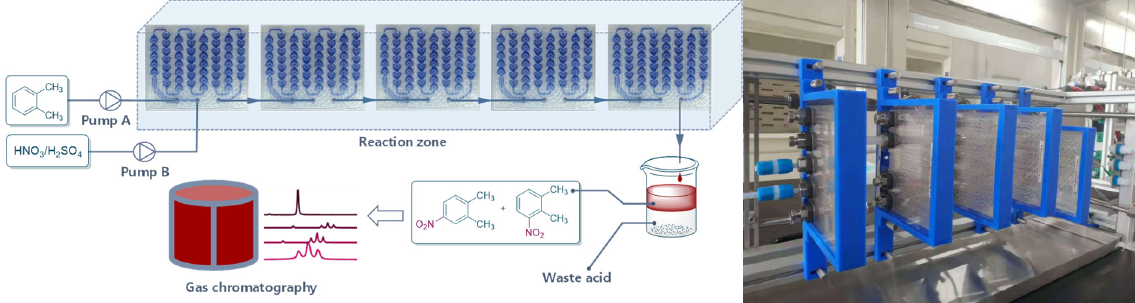
Figure 2. Continuous-flow reactor setup for condition optimization.